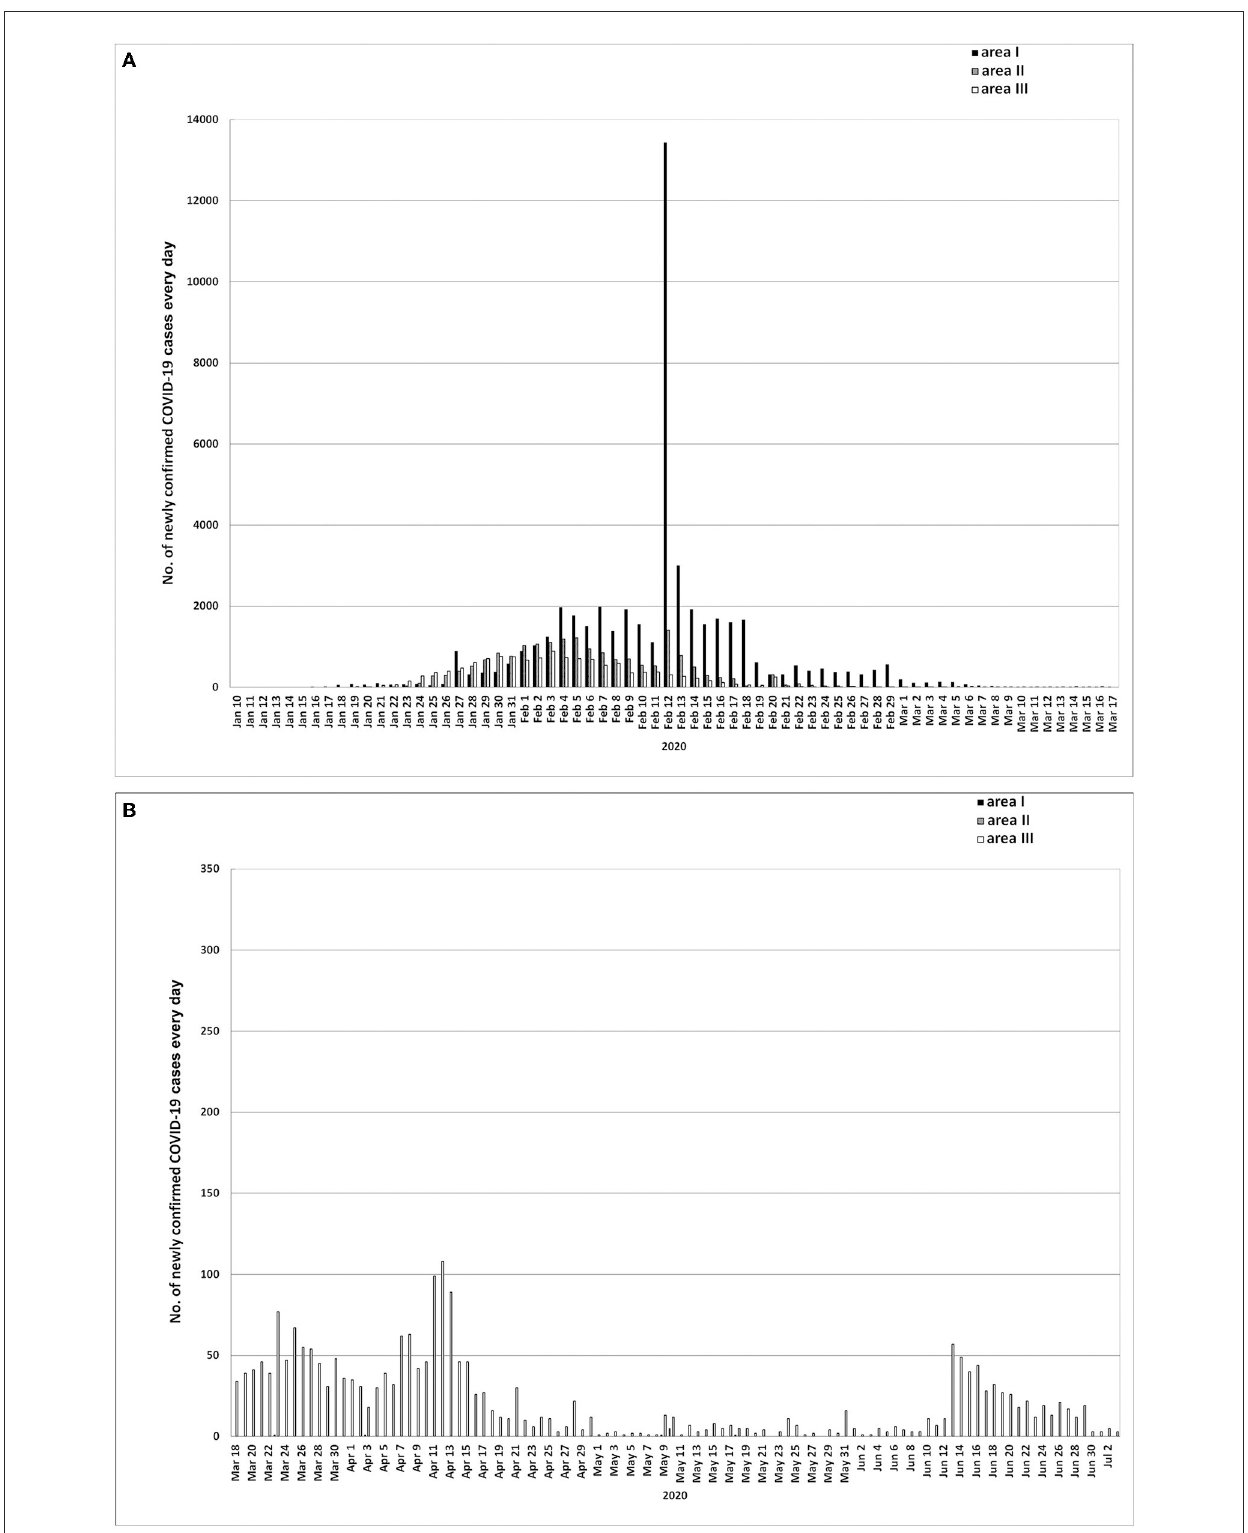
FIGURE2 (A, B) Daily increase of confirmed COVID-19 cases in areas I, II, and III. Area I, Wuhan city. Area II, Hubei province (excluding Wuhan city). Area III, Chinese mainland (excluding Hubei province). From January 12, 2020, the sudden increase of new confirmed cases are related to the clinical cases (Nucleic acid undetected) from Hubei province (including Wuhan) being classified as confirmed cases. COVID-19 cases do not include asymptomatic COVID-19